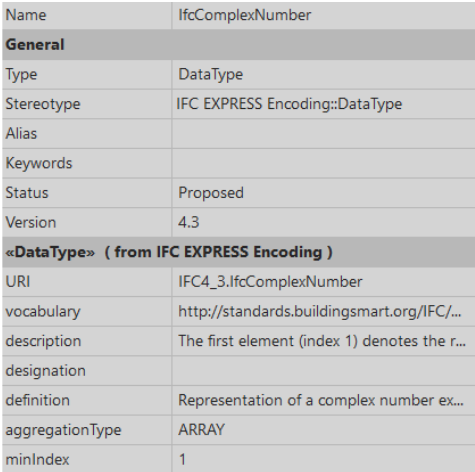
Figure 10. Semantics for a datatype according to the IFC EXPRESS Encoding Profile with merged semantics from the